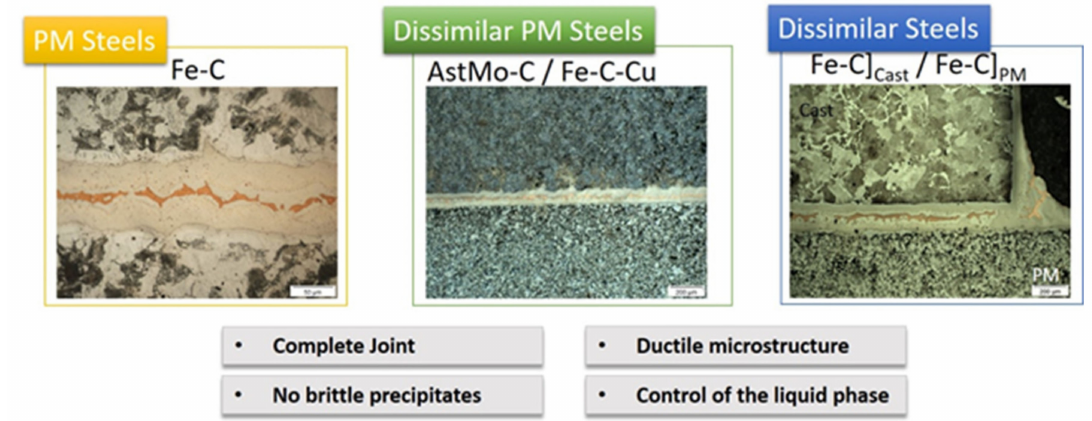
Figure 17. Bonding by sinter brazing of porous or dense substrates of different composition and/or manufacturing. Note the concave meniscus formed at the end of the joint. Left : powder metallurgy (PM) Steels, Middle : Dissimilar PM steels, Right : Dissimilar steels.